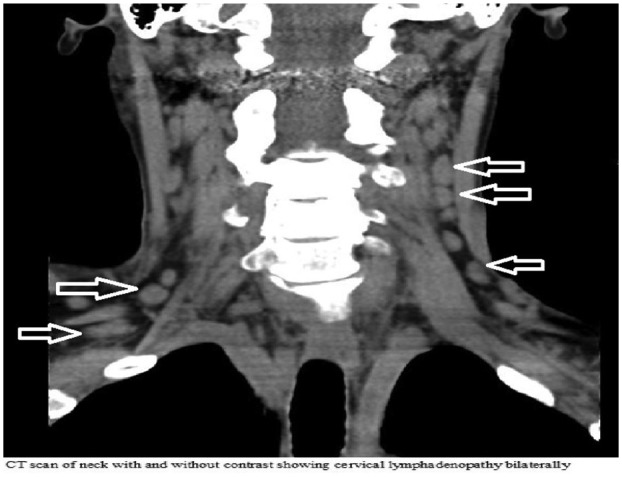
CT scan neck with and without contrast showing bilateral cervical
adenopathy.